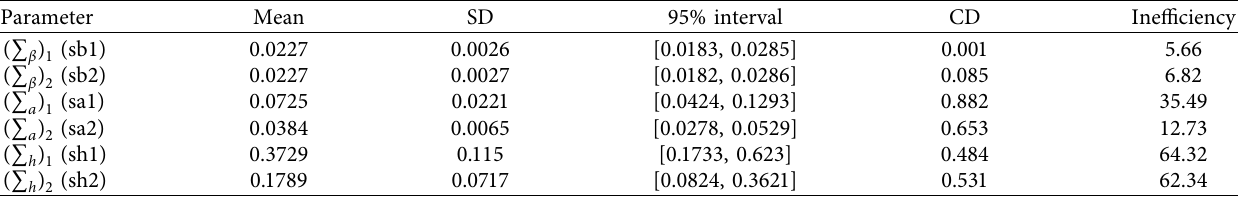
Table 3: Estimation results of the selected parameters in the TVP-VAR model. Parameter